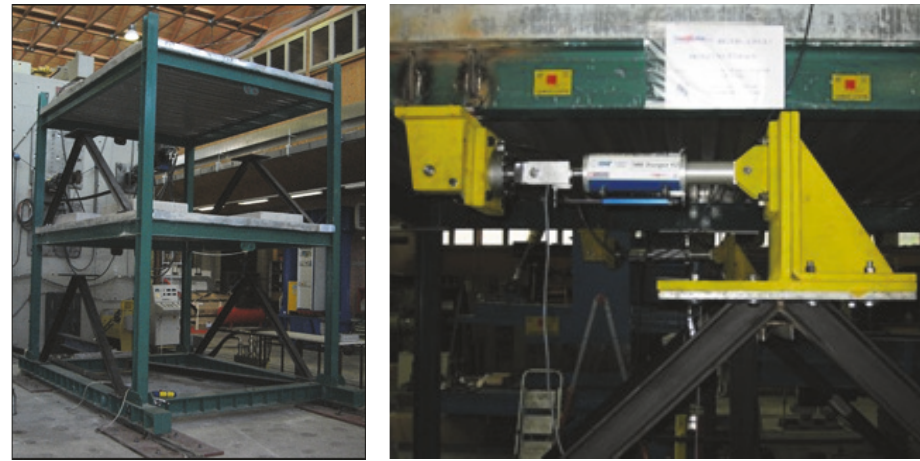
Figure 2: The experimental mock-up structure.